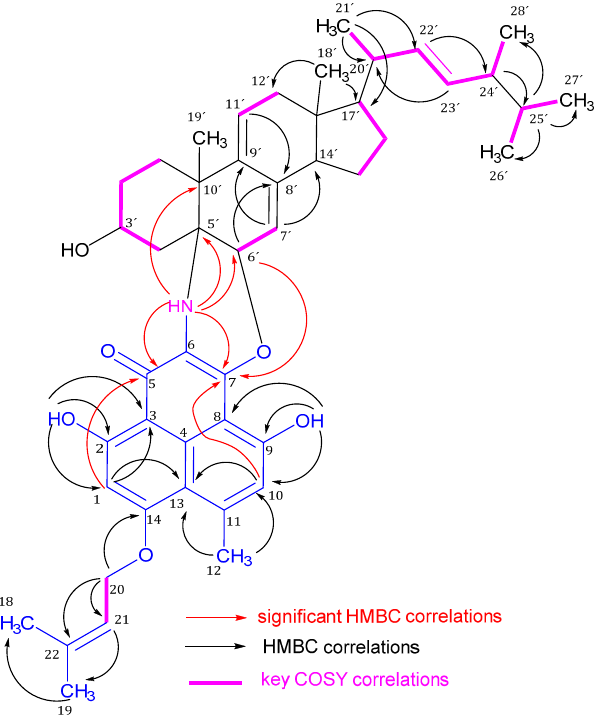
Figure 2. Significant 1 H- 13 C HMBC correlations (arrows, proton to carbon) and 1 H- 1 H COSY (bold lines) of compound 1